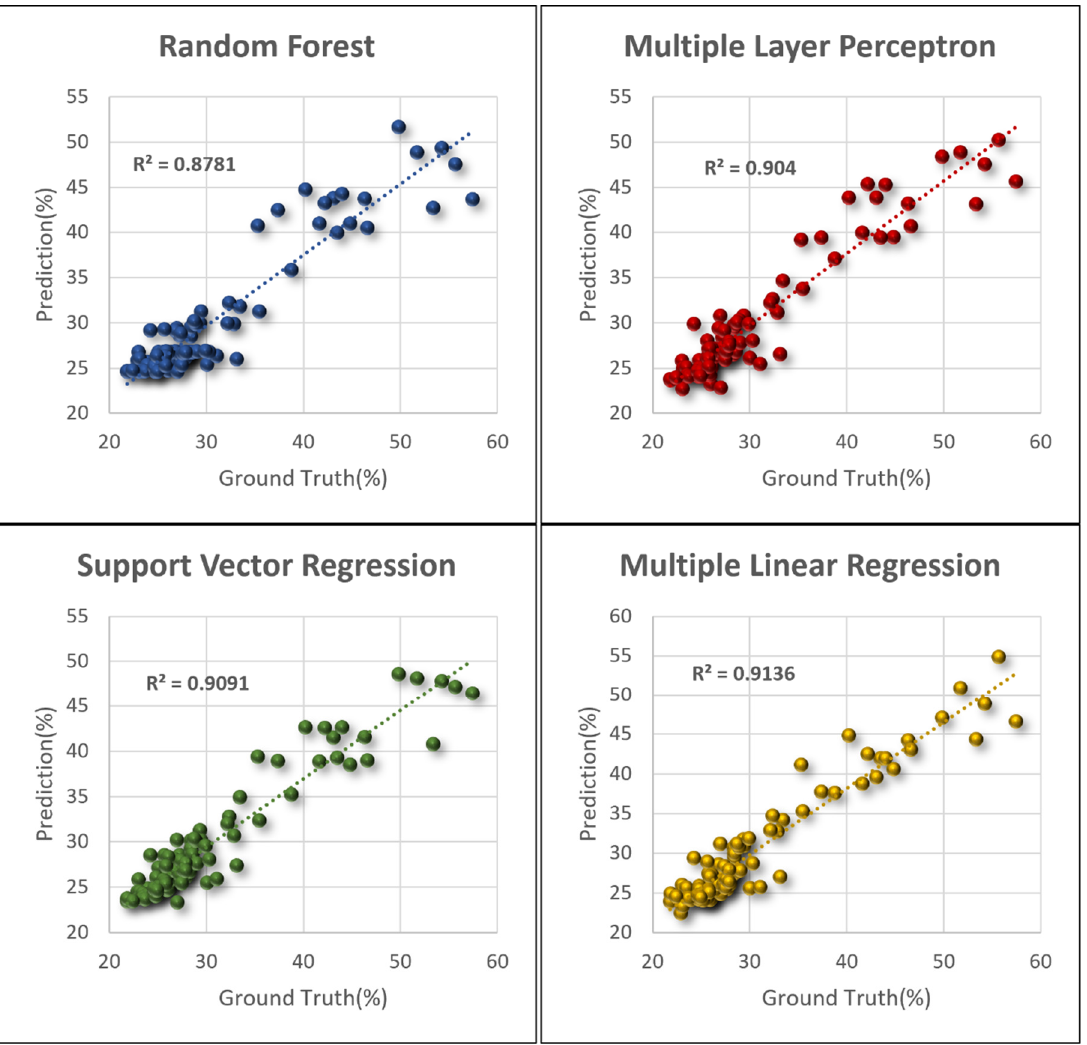
Figure 15. GMC distribution of prediction versus actual data. Table 4. Performance comparison between RF, MLP, SVR, and MLR in different GMC